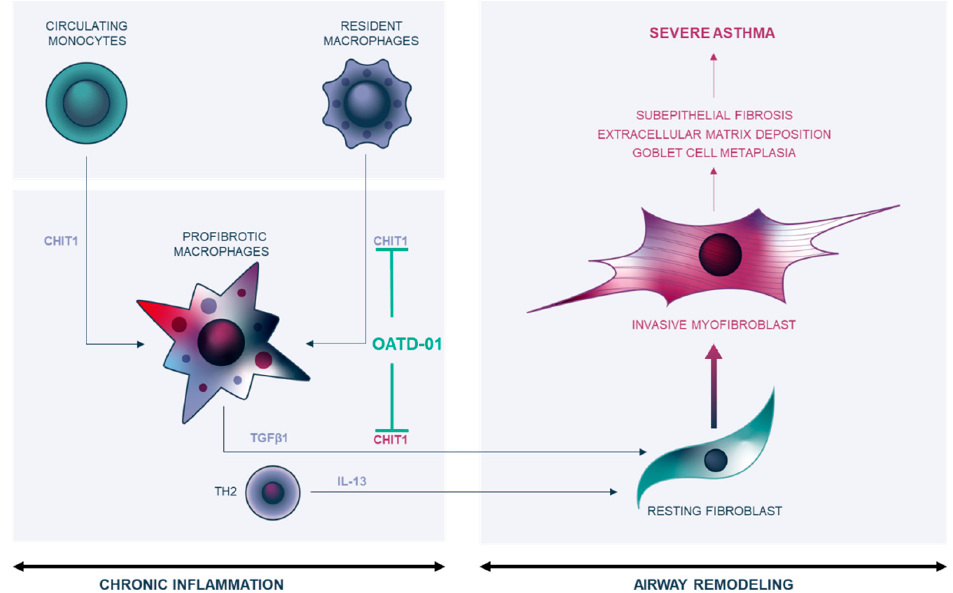
Figure 7. Inhibition of macrophage-specific CHIT1 attenuates airway remodeling. Decreased macrophage-specific CHIT1 expression and activity changes phenotype of profibrotic macrophages and blocks TGF β 1 and subsequent Th2-dependent IL-13 production. OATD-01 inhibits CHIT1-dependent macrophage–fibroblast positive feedback loop leading to fibroblast activation and myofibroblast transition. The overall effect of CHIT1 inhibition results in less collagen deposition in extracellular space, decreased goblet cell hyperplasia, and attenuated airway remodeling—features associated with severe asthma.